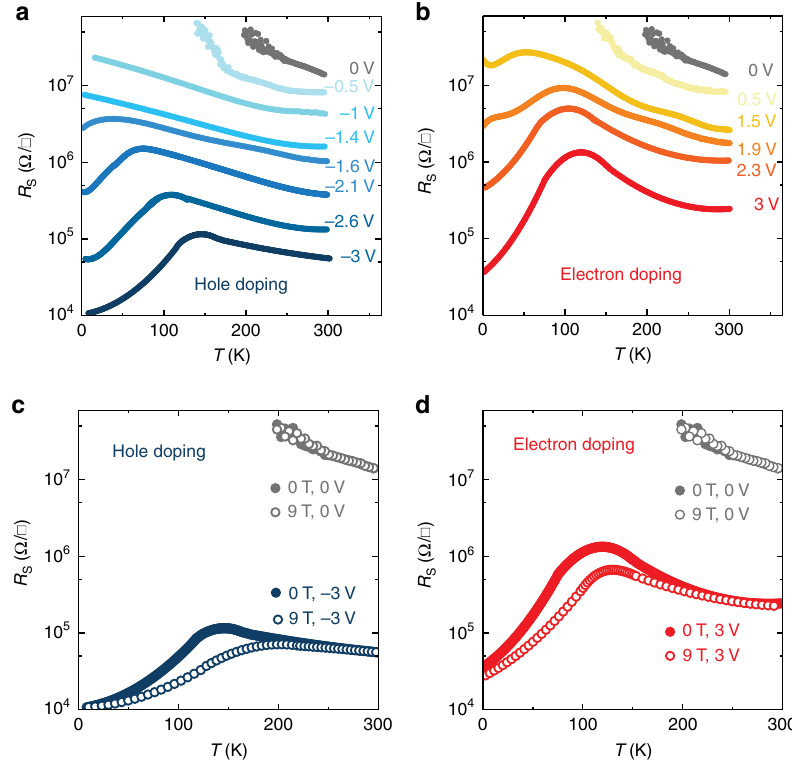
Fig. 3 Metal – insulator transition (MIT) in ionic liquid-gated 3 uc LaMnO 3 . a , b The sheet resistance as a function of gate voltages. Both negative ( a ) and positive ( b ) voltage regimes show a MIT, accompanying the reduction of sheet resistance. c , d Temperature dependence of magnetoresistance in the hole- doped and electron-doped 3 uc LaMnO 3 fi